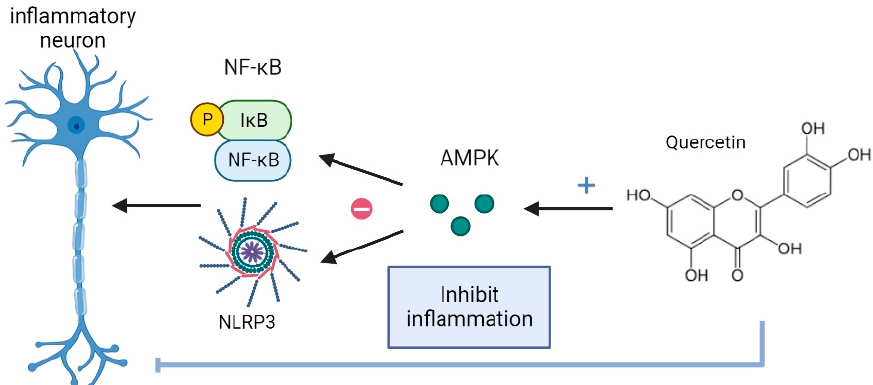
Figure 3. Quercetin is an anti-inflammatory agent via AMPK and is neuroprotective for NF-kB and NLRP3 inflammasome in neuroinflammatory toxicity. AMPK activation by quercetin can inhibit the production of pro-inflammatory cytokines and chemokines, such as TNF- α , IL-1 β , and IL-6, by inhibiting NF- κ B and NLRP3 inflammasome signaling pathways. Quercetin’s anti-inflammatory and neuroprotective effects make it a promising candidate for treating neuroinflammatory disorders, including those associated with exposure to environmental toxins. The image was created in Bio- Render.